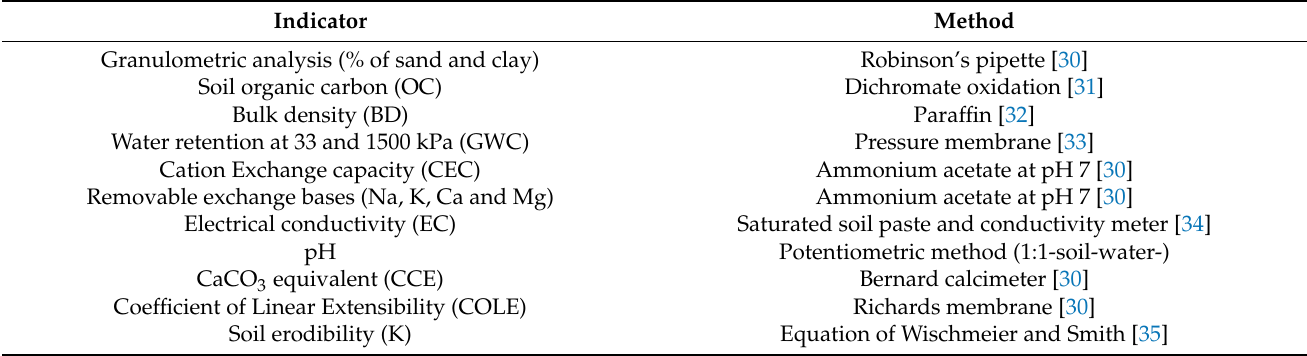
Table 1. Methods used in laboratory analyses for the selected